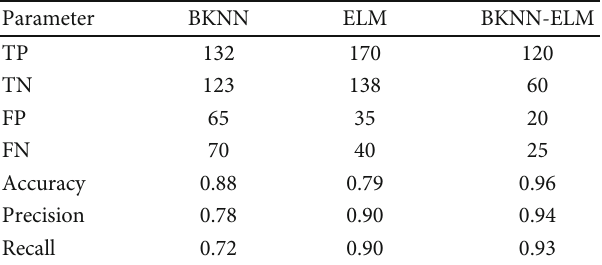
Table 5: Metric measure